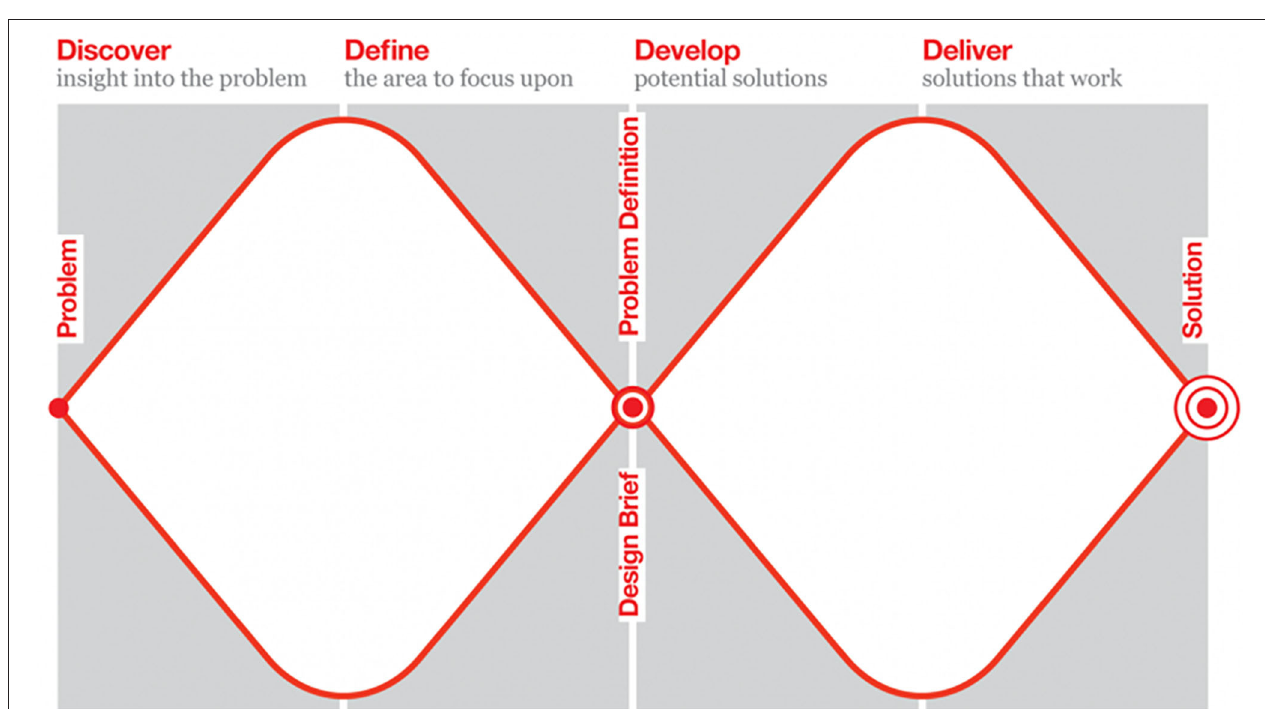
FIGURE 2 | Double diamond model (Tschimmel,